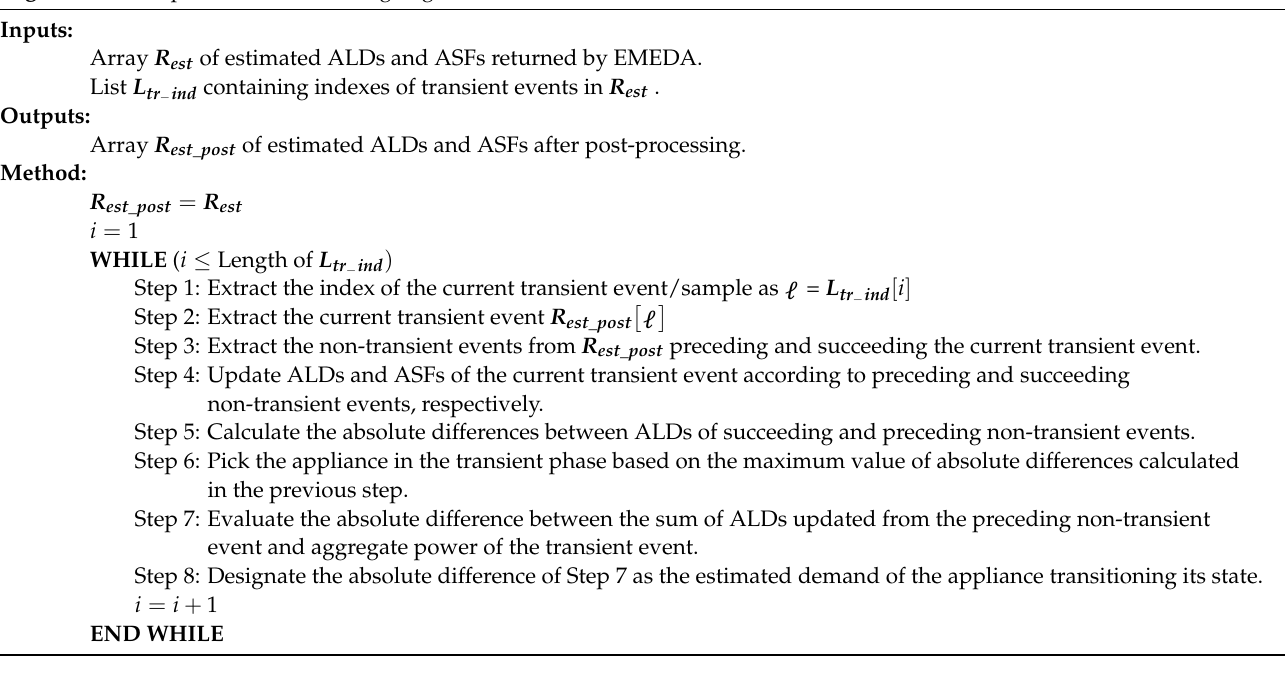
Algorithm 4: Proposed Post-Processing Algorithm